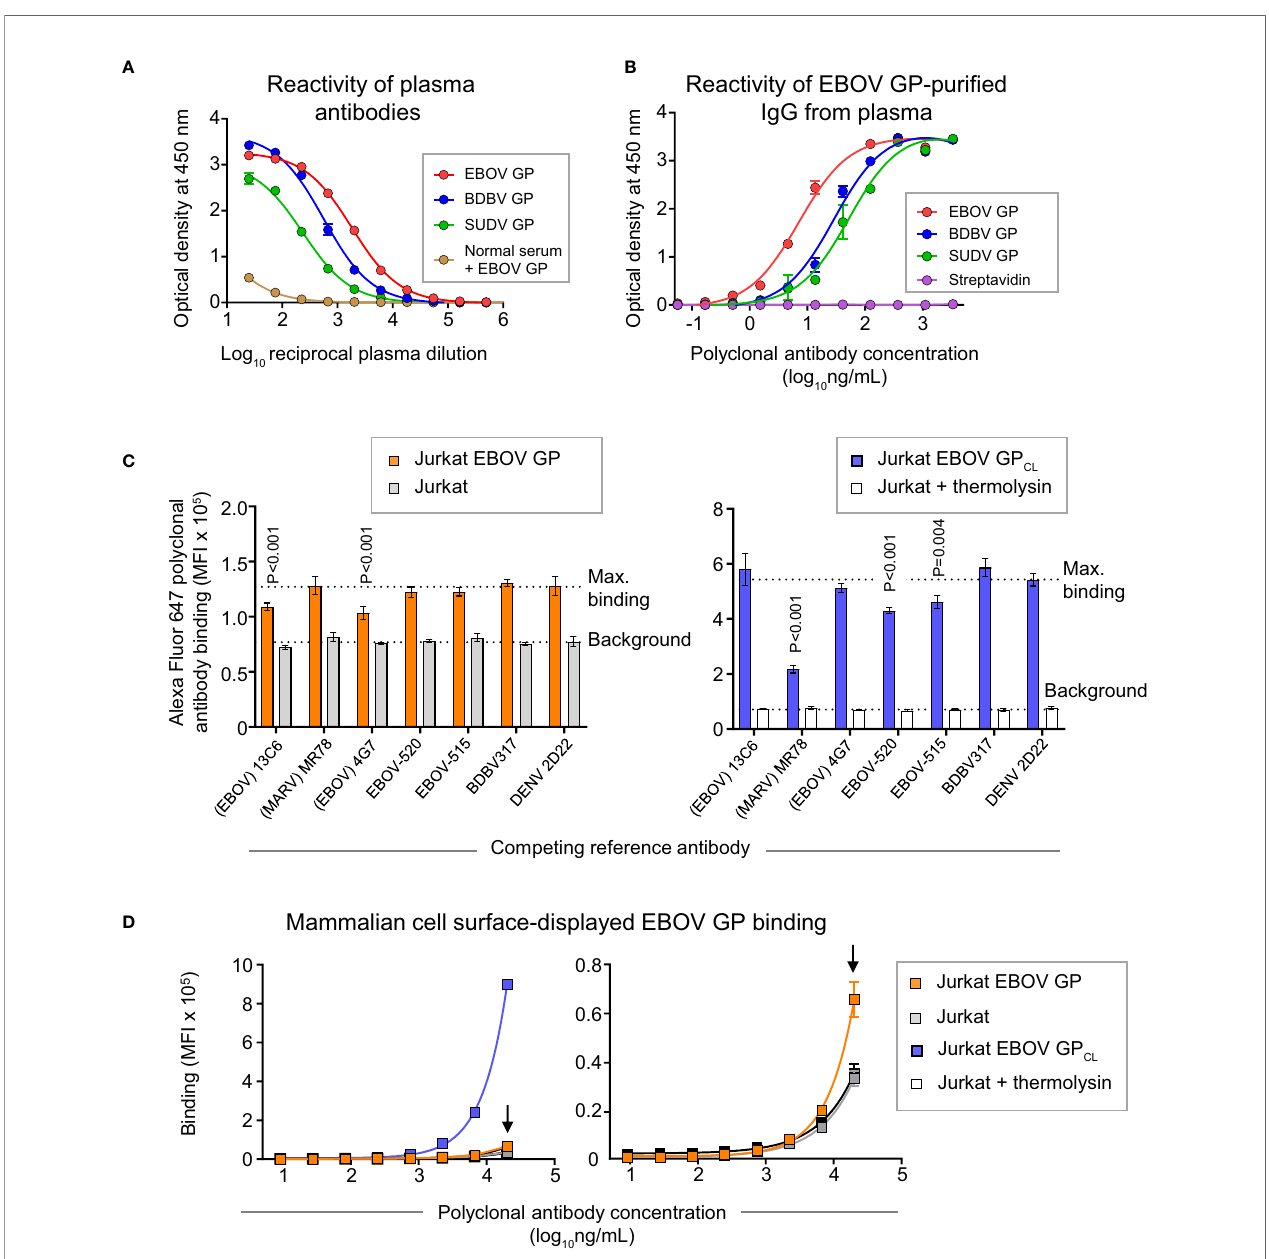
FIGURE 2 | GP recognition, reactivity breadth, and competition binding pro fi les identi fi ed for polyclonal antibody response in convalescent plasma from an EVD survivor. (A) Dose-response binding of antibodies in the survivor ’ s plasma to recombinant EBOV, BDBV, or SUDV GP proteins was assessed by ELISA. Mean ± SD of technical triplicates from one experiment are shown. Binding of serum antibodies to EBOV GP from an individual without prior EBOV exposure served as the control for the level of speci fi c binding. (B) Dose-response binding of polyclonal IgG antibodies that were af fi nity puri fi ed from plasma tested in panel (A) using an EBOV GP-coupled column was assessed by ELISA using recombinant EBOV, BDBV, or SUDV GP proteins. Mean ± SD of technical triplicates from one experiment are shown. (C) Competition-binding analysis of Alexa Fluor 647-labeled puri fi ed polyclonal antibodies to mammalian cell surface-displayed GP. Antibodies were puri fi ed from plasma as in panel (B) and labeled with Alexa Fluor 647. Jurkat-EBOV GP cells (left) or Jurkat-EBOV GP cells that were pre-treated with thermolysin to generate cleaved GP (designated as Jurkat-EBOV GP CL [right]) were pre-incubated with in the presence of indicated monoclonal antibody with known epitope speci fi city followed by incubation with fl uorescently-labeled polyclonal antibodies and fl ow cytometric analysis. Competition was quanti fi ed by comparing labeled polyclonal antibody binding in the presence of indicated competing mAb to the level of maximal binding (upper dotted line) estimated from binding of labeled polyclonal antibodies in the presence of the dengue virus-speci fi c antibody DENV 2D22. Binding to untransduced (mock) Jurkat cells (open bars) served as control for the background (lower dotted line). Mean ± SD of technical duplicates from two experiments are shown. Binding in the presence of each indicated mAb was compared to the maximal binding control using ordinary one-way ANOVA with Dunnett ’ s multiple comparisons test, and P-values for signi fi cant differences are indicated. (D) Dose-response binding curves of puri fi ed fl uorescently-labeled polyclonal IgG to Jurkat-EBOV or Jurkat-EBOV GP CL cells determined by fl ow cytometric analysis. Mean ± SD of technical triplicates from one experiment are